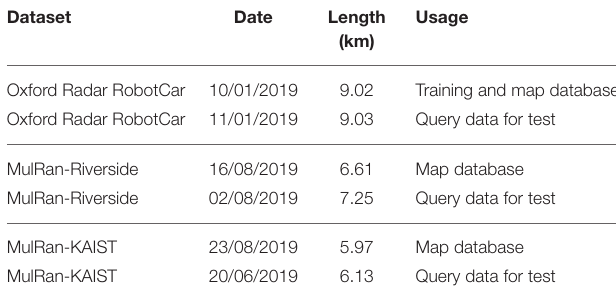
TABLE 1 | Sequences for training and